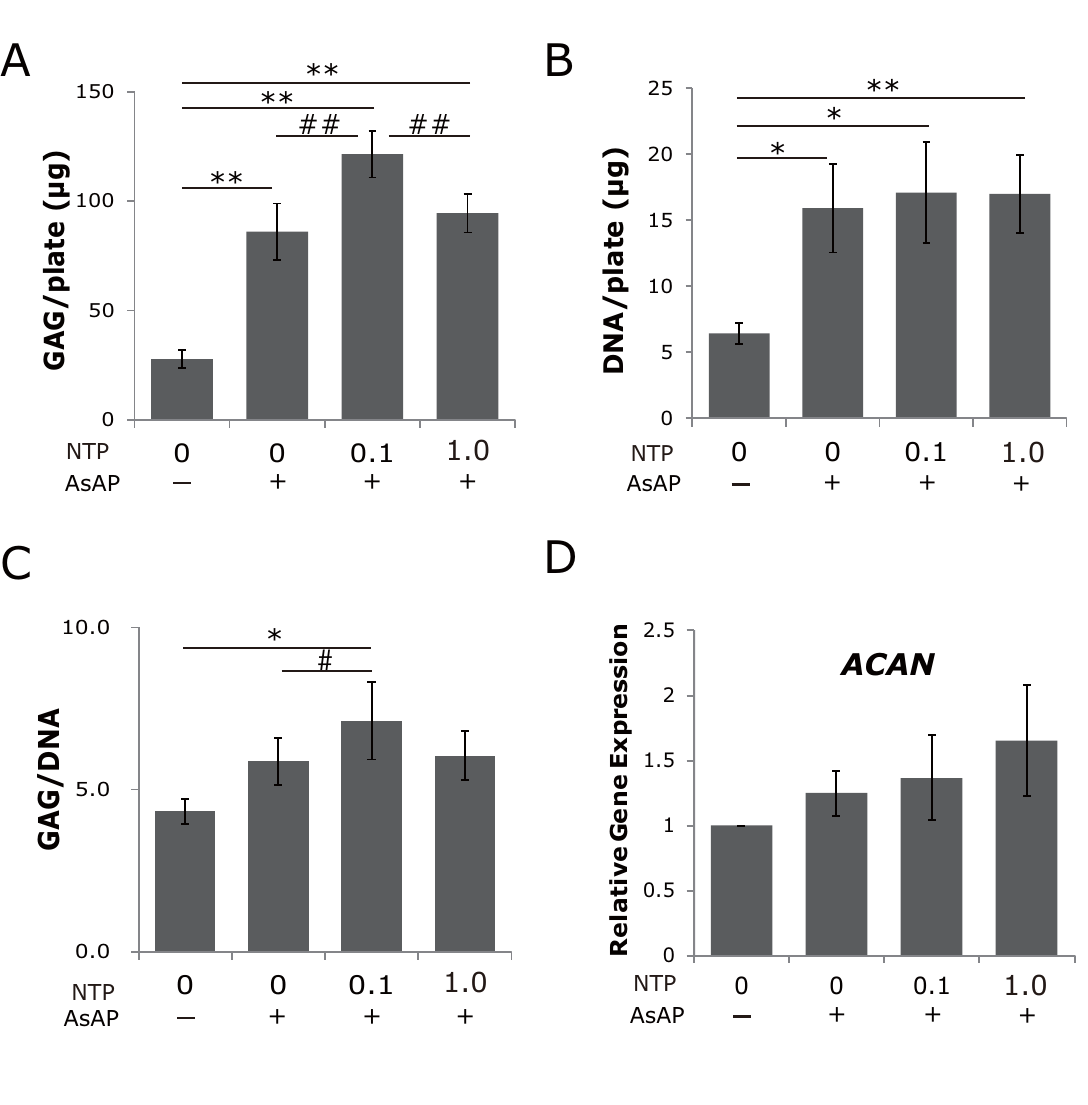
Fig 2. Effect of Neurotropin (NTP) on production of sulfated glycosaminoglycans. A) After two weeks of culture, glycosaminoglycan (GAG) content per plate increased in cultures with added AsAP, with or without the addition of NTP. B) DNA content increased in cultures with added AsAP, with or without the addition of NTP. C) GAG content normalized to DNA content was significantly upregulated by addition of 0.1 mNU/ ml NTP with AsAP. D) After one week of culture, the effect of NTP on aggrecan ( ACAN ) mRNA expression was measured by real-time quantitative PCR. Gene expression of ACAN normalized to GAPDH showed a tendency to increase with increasing concentrations of NTP. Data are presented as the average ± standard error ( (cid:3)(cid:3) p < 0.01, (cid:3) p < 0.05 when compared with control, ## p < 0.01, # p < 0.05 when compared with AsAP alone, and †† p < 0.01, when compared between NTP–treated samples, N =